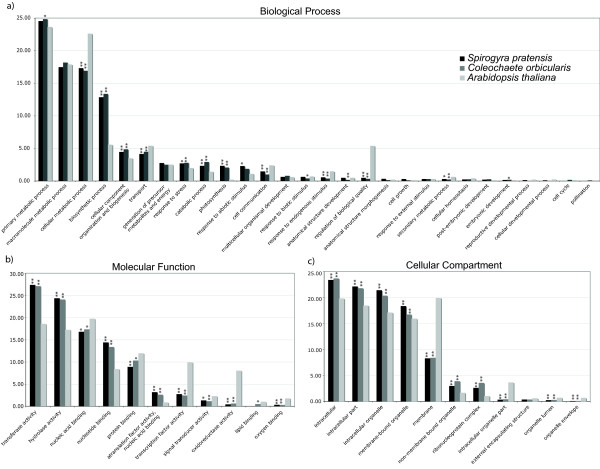
Gene Ontology. The relative proportion of Gene Ontologies for both charophyte ESTs shown against Arabidopsis thaliana proteins as a relative measure. Each graph represents 100% of the GO annotations for each species. The x-axis contains the GO categories, the y-axis shows the proportion of genes in each category. Fisher's exact test (based on a hypergeometric distribution) was used to calculate significance levels for overrepresentation or underrepresentation of each charophyte verses the reference, A. thaliana (* p < 0.01, ** p < 0.001).